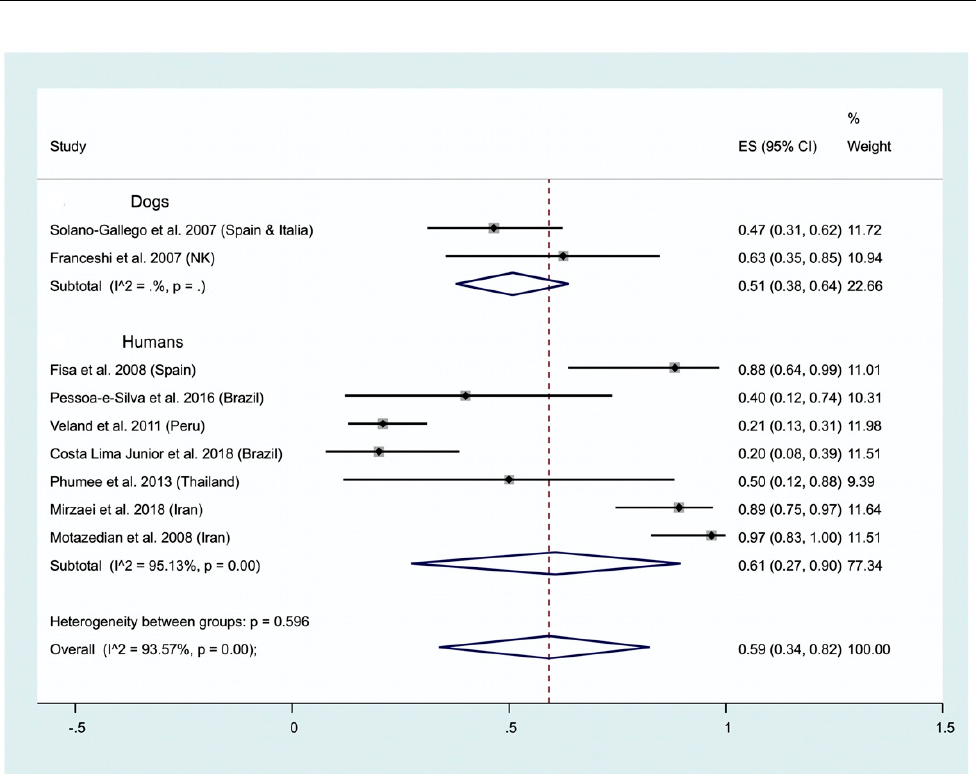
Figure 3. Forest plot representation of the extracted data for urine analysis using molecular methods on leishmaniasis with subgroup analysis on dogs and humans.